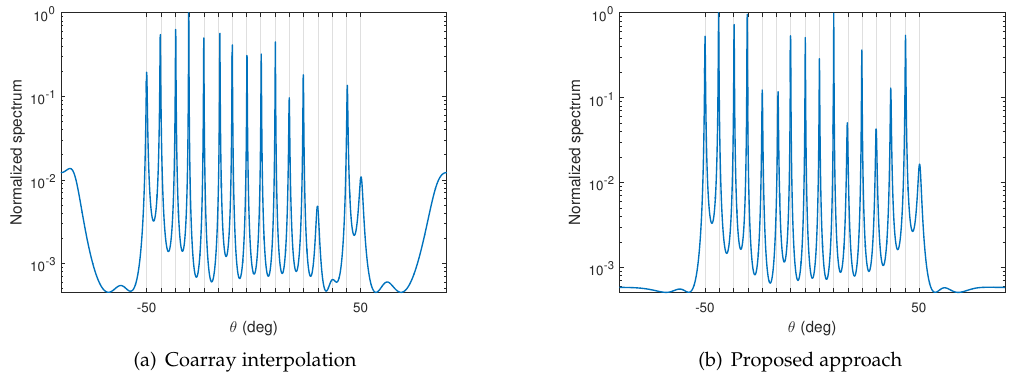
Figure 2. Spectrum comparison between two approaches. The number of snapshots is K = 100 and signal-to-noise ratio (SNR) is 0 dB. ( a ) Coarray interpolation in [20]; ( b ) Proposed